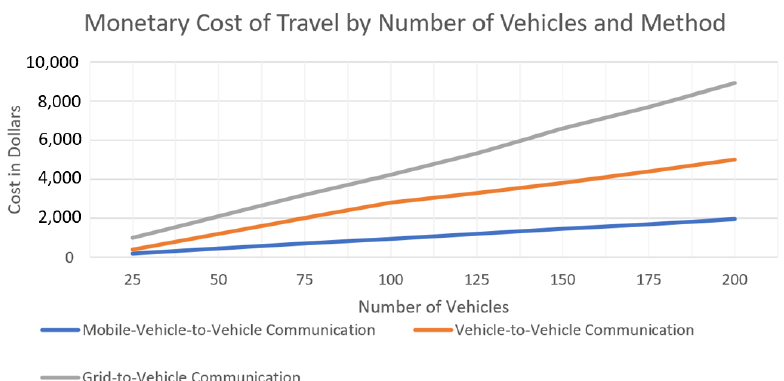
Figure 21. A graph showing the cost to transport CAVs based on method, adopted from